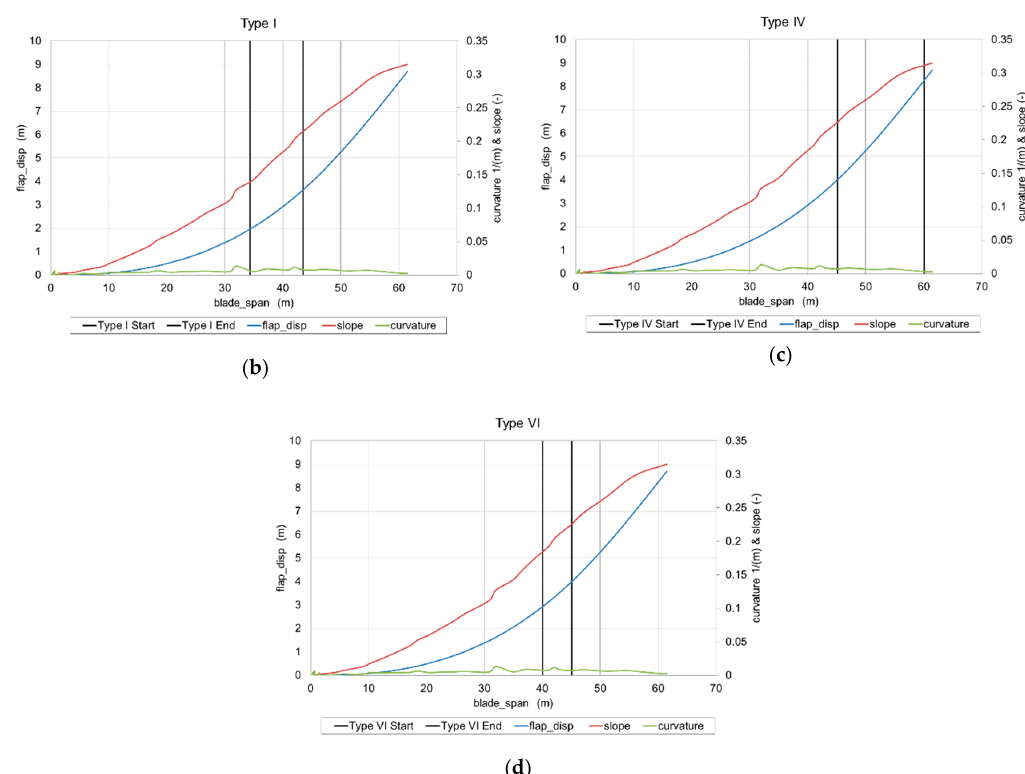
Figure 2. ( a ) Flap deflection, slope, and curvature of the first eigenmode of the considered wind turbine (WT) blade, ( b ) location of tip accumulator of type I, ( c ) location of tip accumulators of type IV, and ( d ) location of tip accumulators of type VI.